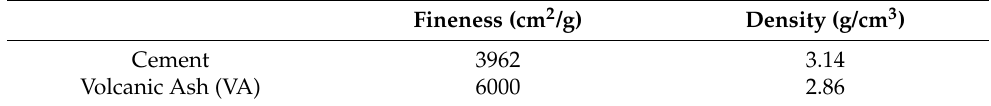
Table 2. Results of the fineness and density.